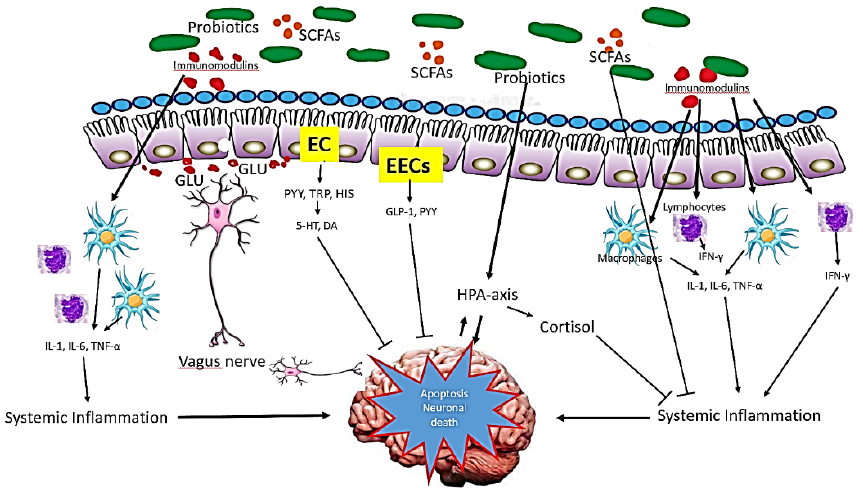
Figure 3. Mechanism of action of probiotics in AD. The probiotics influence brain function via three main function: immune modulation, endocrine pathways and neuronal regulation. Small chain fatty acids (SCFAs), the main metabolites produced by the fermentation of gut microbiota, suppress pro-inflammatory mediators while upregulating the anti-inflammatory mediators. Via endocrine pathways, probiotics activate the hypothalamic-pituitary-adrenal (HPA) axis, stimulate adrenal release of cortisol, which is the most potent anti-inflammatory hormone. Probiotics also stimulate the production of glucagon-like-peptide-1 (GLP-1) and peptide YY (PYY) hormones by intestine enteroendocrine L-cells (EECs). Further, probiotics secrete certain neurotransmitters such as glutamate (GLU) or modulate the secretion of neurotransmitters via enterochromaffin cells (EC) such as serotonin (5-HT). These neurotransmitters and neuroactive metabolites exert neuroprotective effects in concert, preventing neuronal